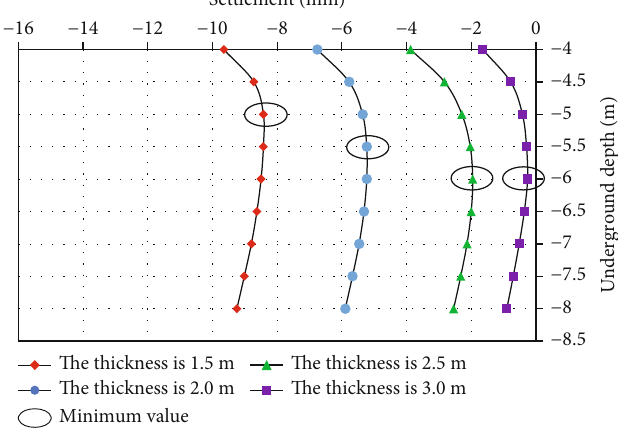
The thickness is 2.5 m The thickness is 3.0 m